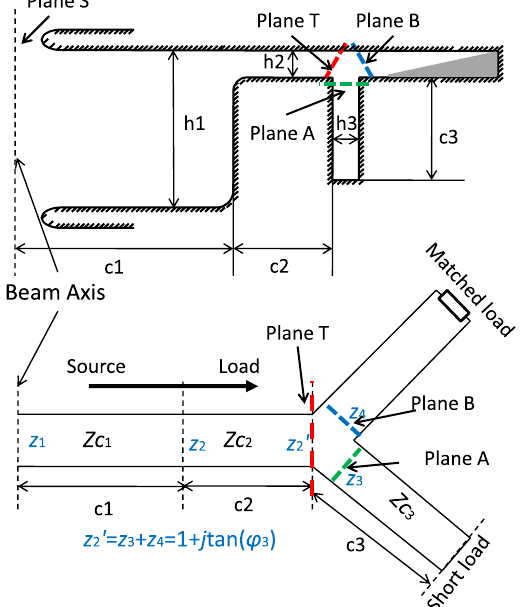
FIG. 2. The transmission line model for choke-mode cavity. The subscripts i ¼ 1 ; 2 ; 3 , and 4 represent variables of the main cavity, the inner radial line, the choke structure, and the outer radial line, respectively. c i is the size (radius) of each branch; Z ci is the characteristic impedance; ’ i is the phase advance for a traveling wave through each branch. If we consider the beam axis (reference plane S) as source, z i is the equivalent impedance at each reference